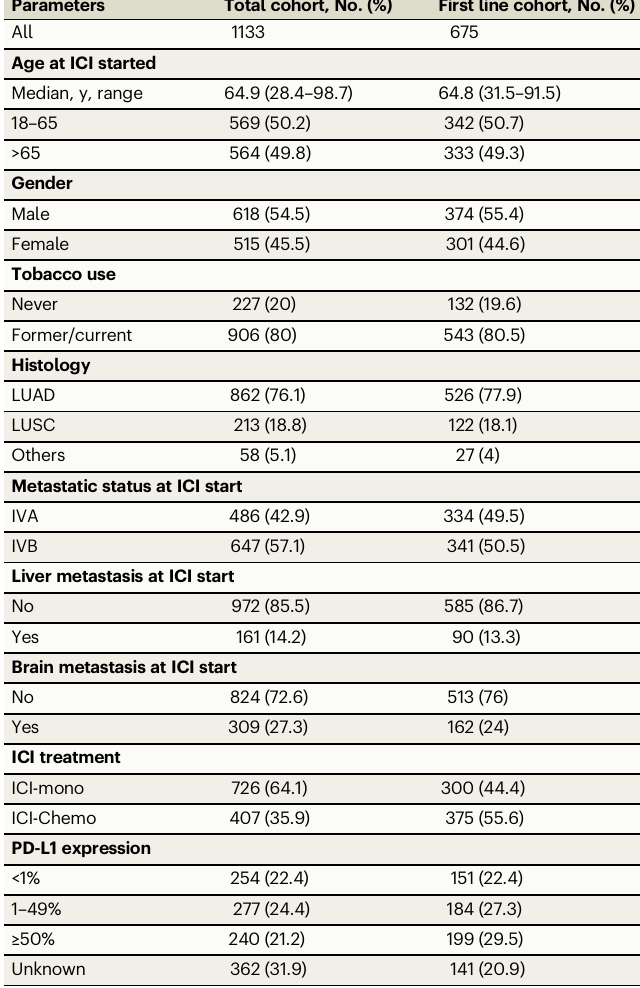
Table 1 | Clinicopathological characteristics of the entire cohort and fi rst-line setting Parameters Total cohort, No. (%) First line cohort, No.